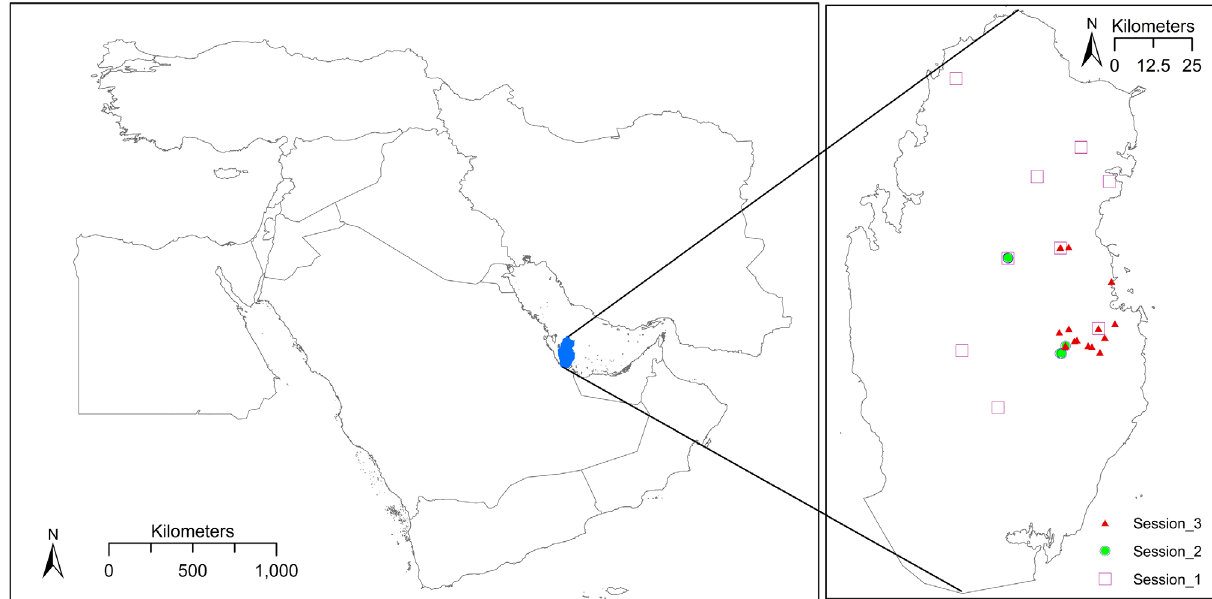
Figure 1. Study area and site locations. A. Location of the study area: Qatar, Middle East; B. Location of the study sites. White squares: Session 1 – longitudinal data, 2017 – 2018; Green circles: Session 2 – fi eld survey, September 2017; Red triangles: Session 3 – cross-sectional fi eld study, January